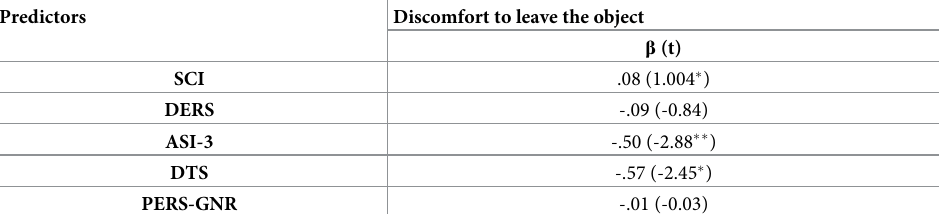
Table 5. Linear regression models for the self-report questionnaires and the discomfort of leaving the object (T1), considering the high-HD